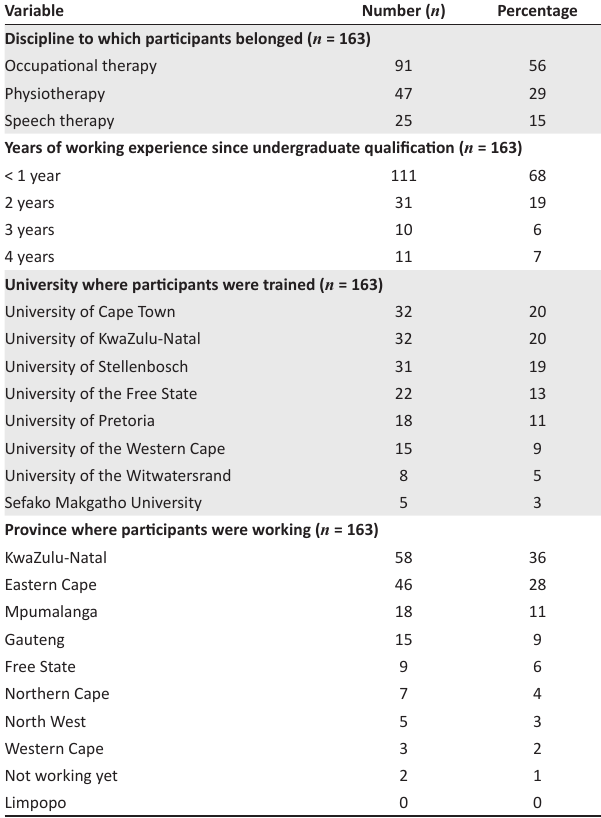
TABLE 1: Profile of participants who attended the